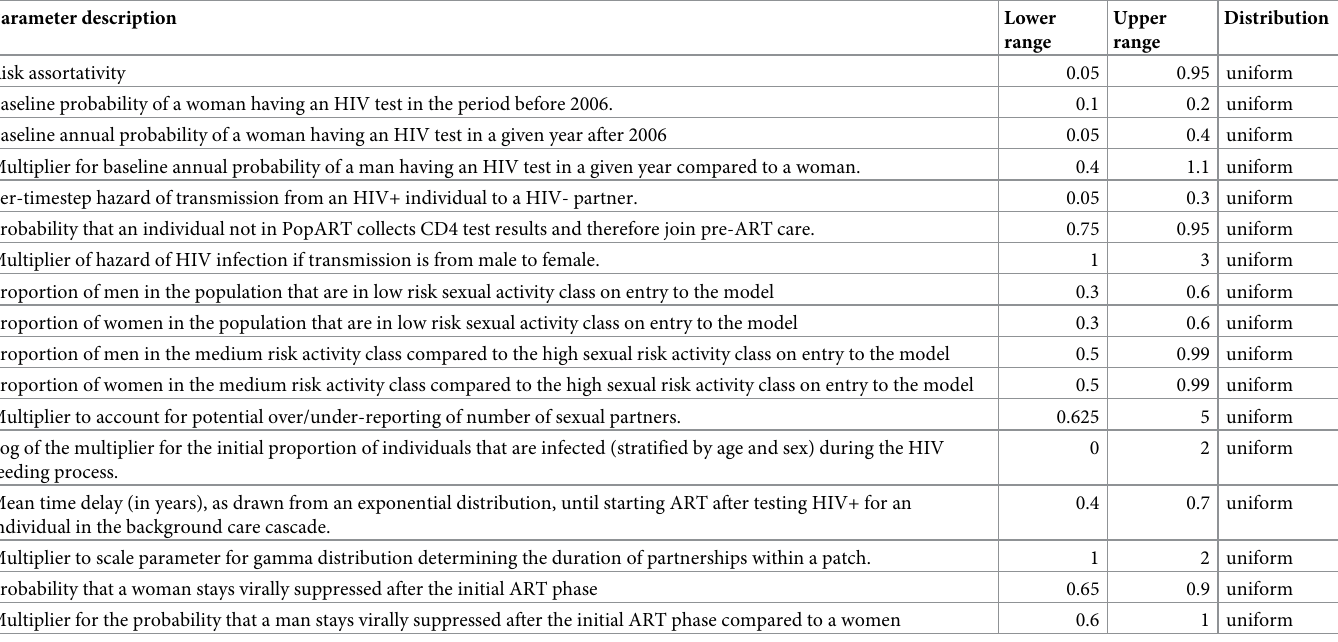
teams from 2013–2017 as part of the HPTN 071 (PopART) trial intervention in one trial com- munity. We use as summary statistics HIV prevalence (4 rounds of PC surveys, 3 rounds of